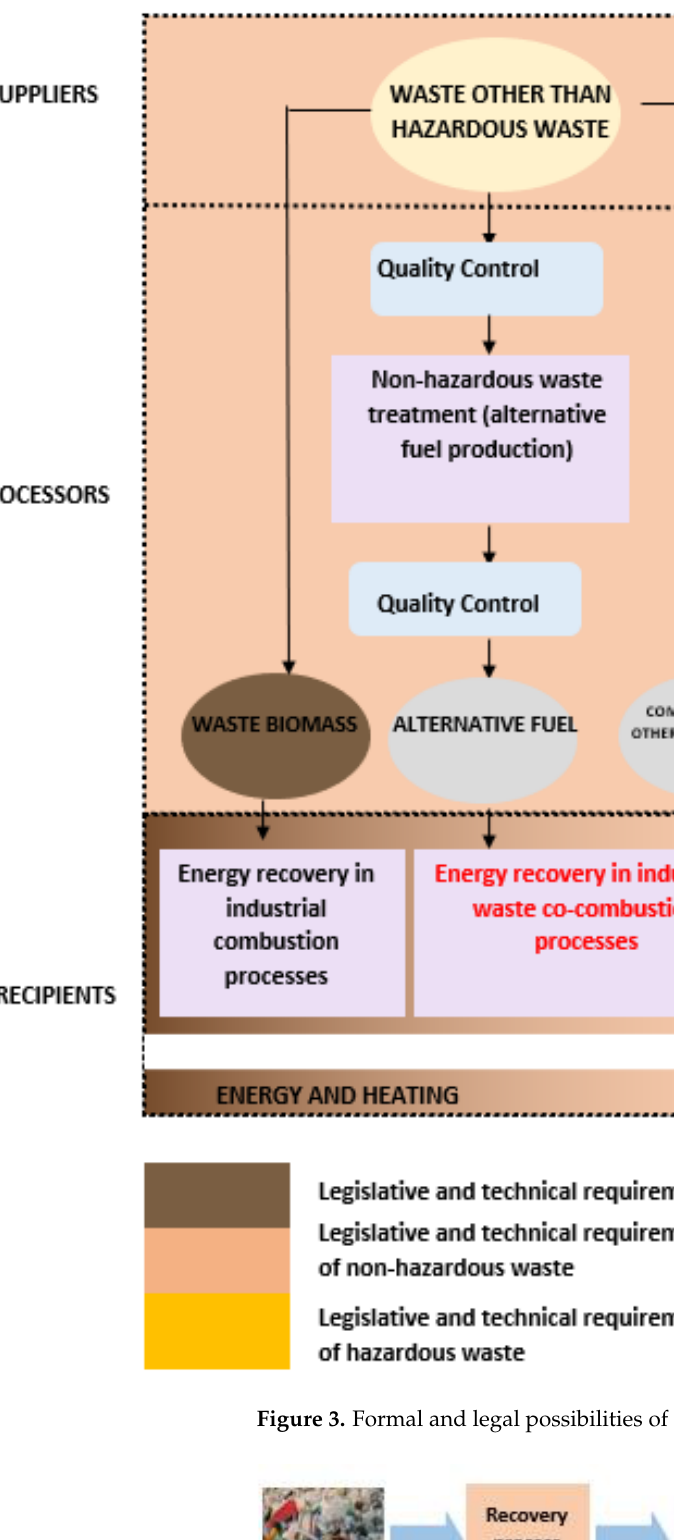
Figure 3. Formal and legal possibilities of energy recovery from waste [25].